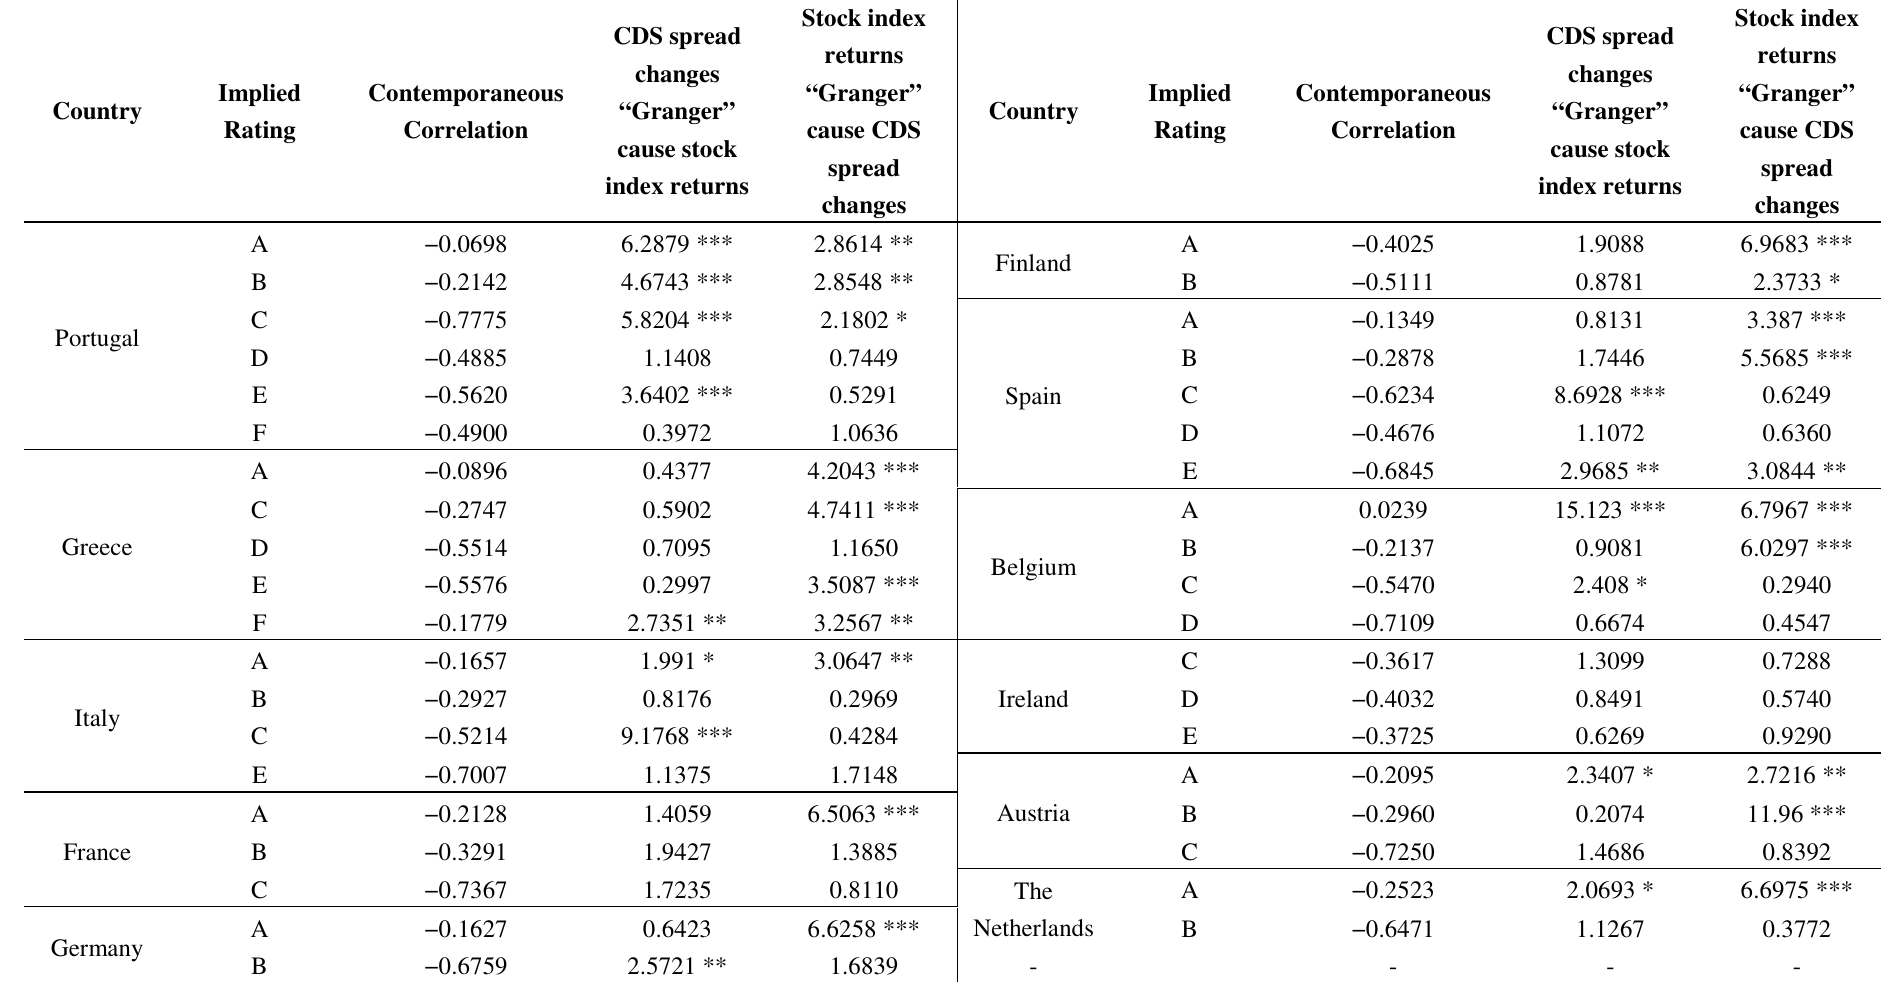
Table 4. Correlation and “Granger” causality between stock returns and credit default swaps (CDS) spread changes.